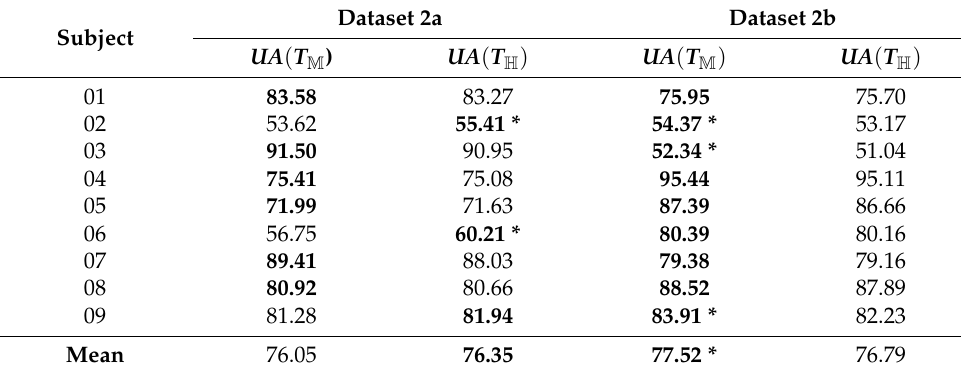
Table 6. Comparison between the proposed adaptive threshold and the method from [39], using subject-specific classification.